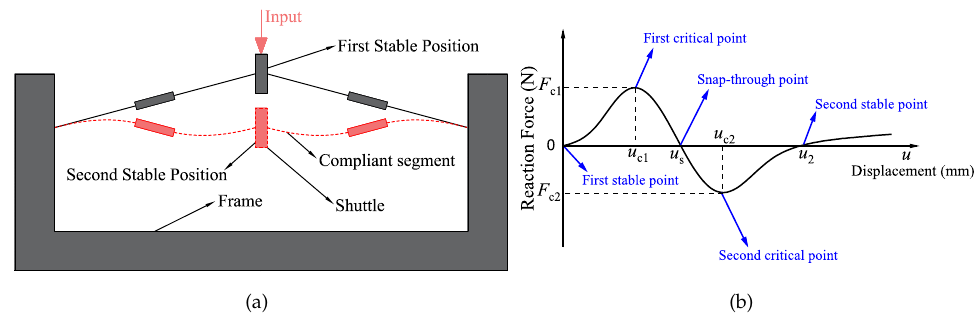
Figure 1. Traditional compliant bistable mechanism: ( a ) the design; ( b ) the force–displacement curve.